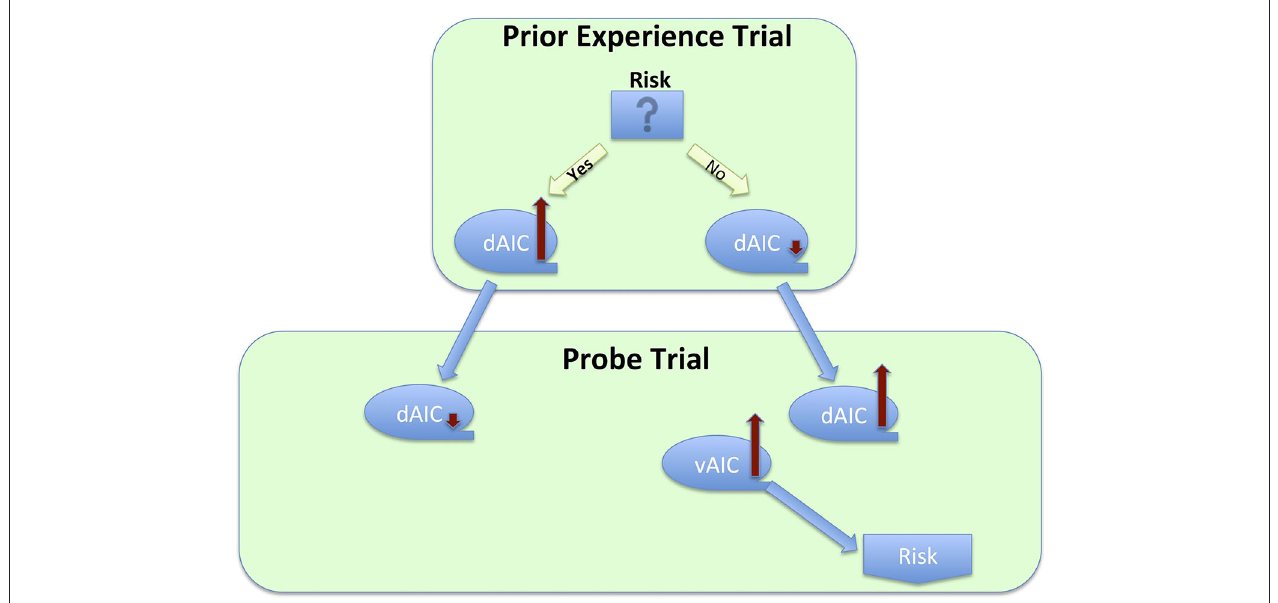
FIGURE 6 | Process flow of a series of decisions between risky and safe option, and corresponding changes in activation across sub-regions of the insula